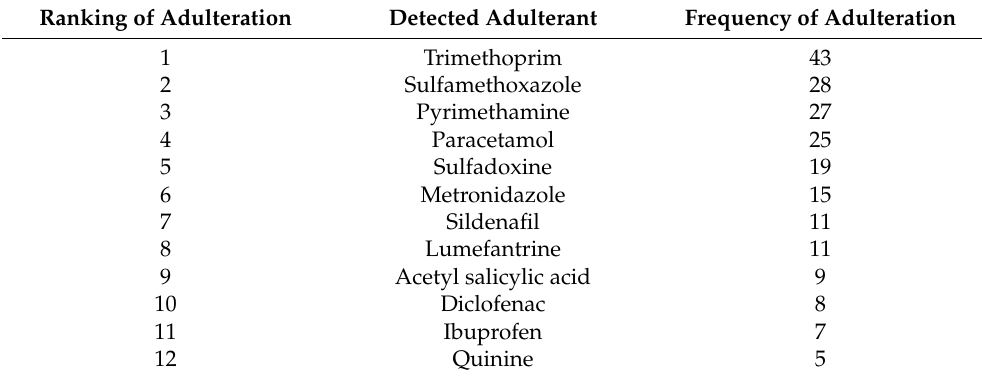
Table 4. Frequency of adulteration of herbal